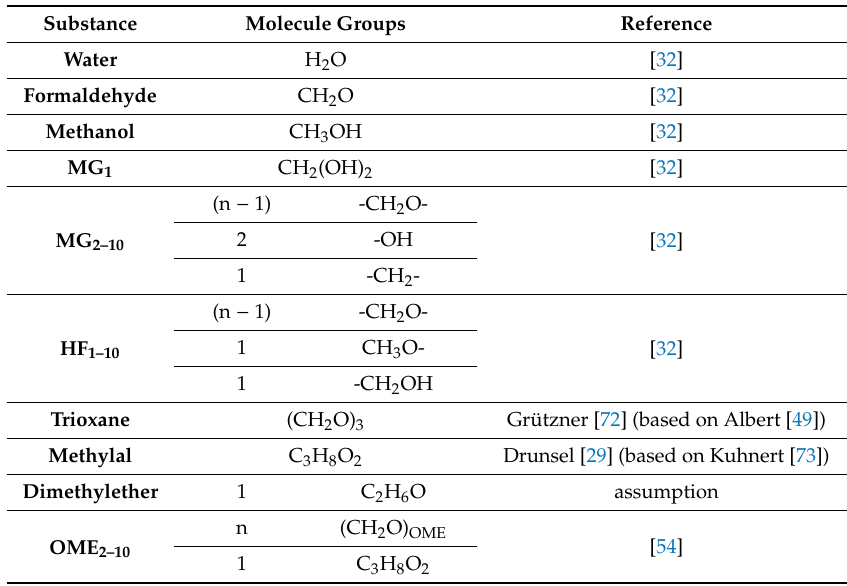
Table A2. UNIFAC